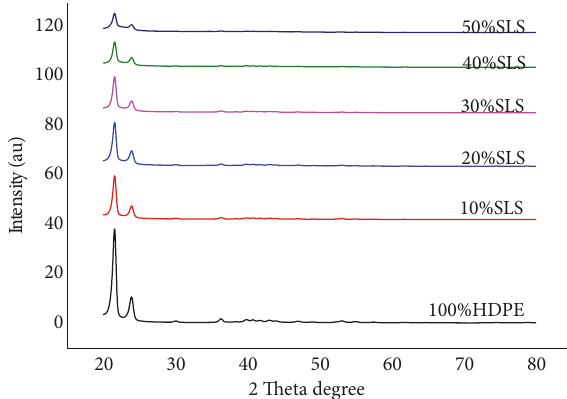
Figure 4: Variation in dielectric constant of SLS-HDPE composites.